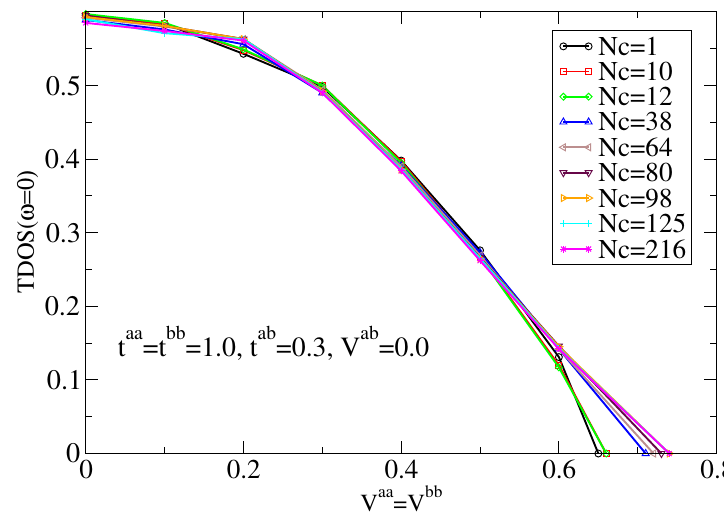
Figure 35. The TDOS at the band center ( ω = 0) vs. V aa = V bb in the a-b two-orbital model with increasing cluster size, for t aa = t bb = 1.0, t ab = 0.3, V ab = 0.0. For N c = 1, the critical disorder strength is 0.65 and as N c increases, it increases and converges to 0.74 for N c = 98. Reprint from